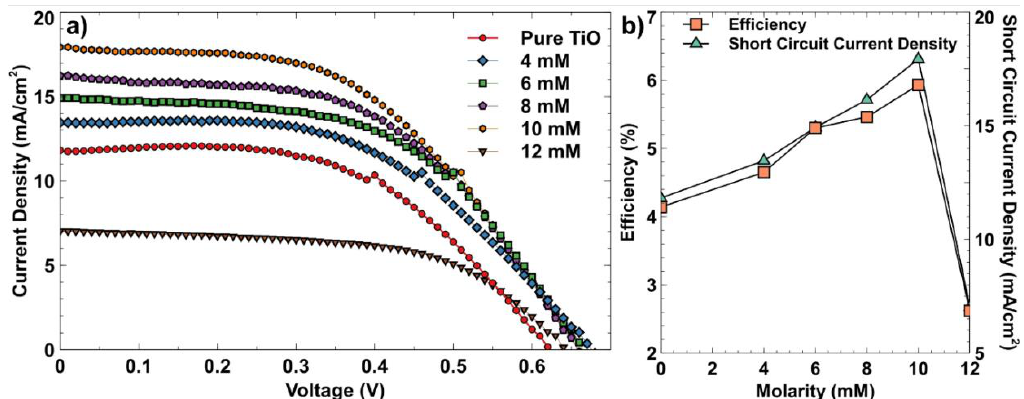
Figure 9. ( a ) I – V characteristic ( b ) power conversion efficiency and short circuit current density for Figure 9. ( a ) I–V characteristic ( b ) power conversion e ffi ciency and short circuit current density for different concentration of sodium citrate. di ff erent concentration of sodium citrate. Table 2. Photovoltaics parameter of DSSC for di ff erent sodium citrate